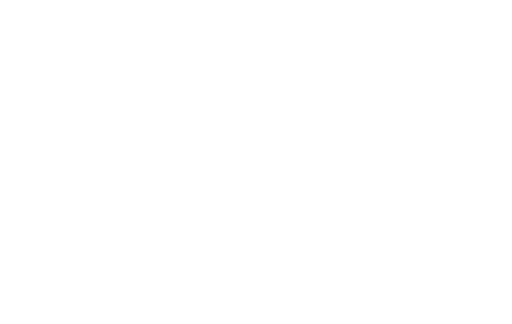
Table 3. Implanted